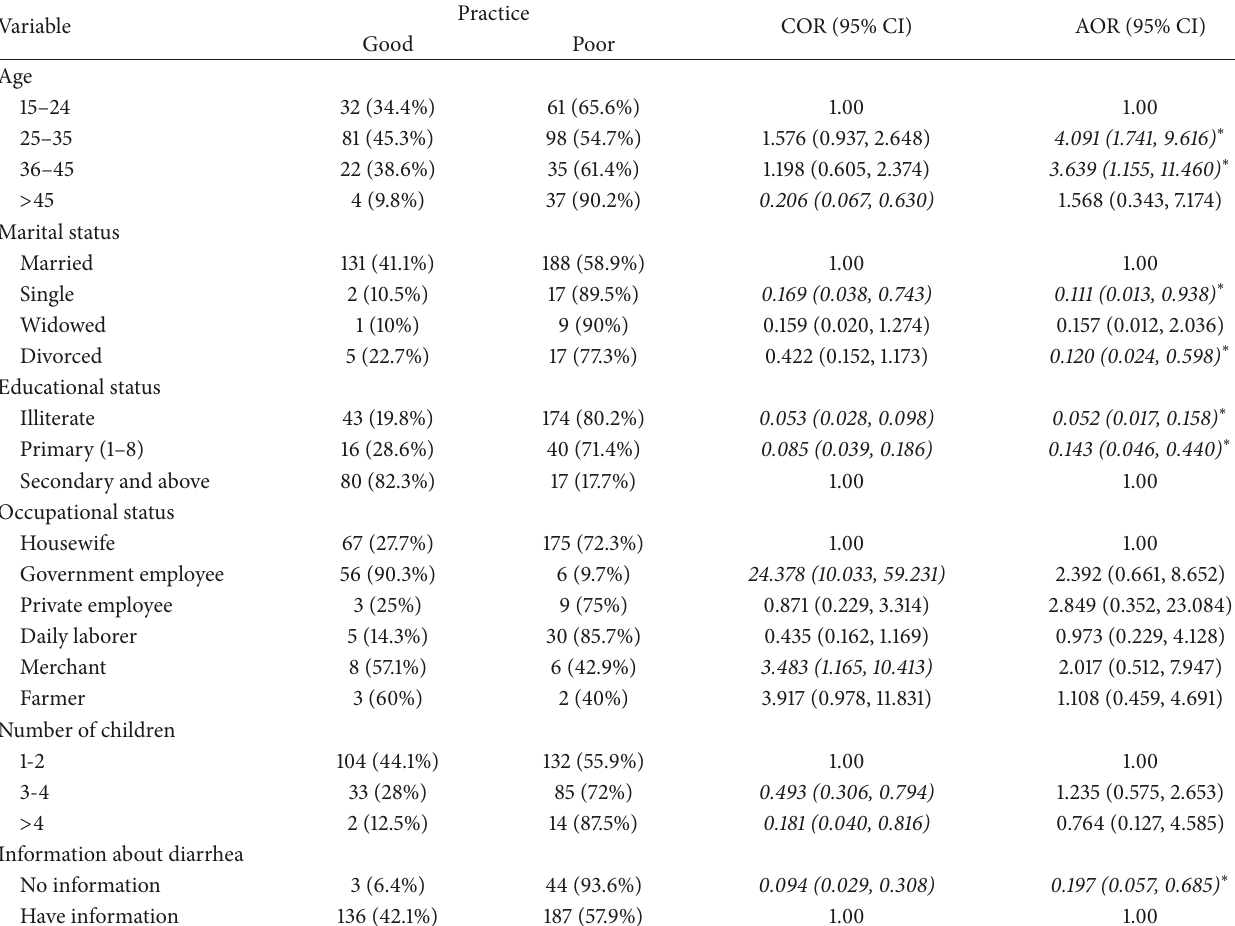
Table 3: Factors associated with practice of home management of diarrhea among caregivers attending under-five clinic in Fagita Lekoma district, Northwest Ethiopia,